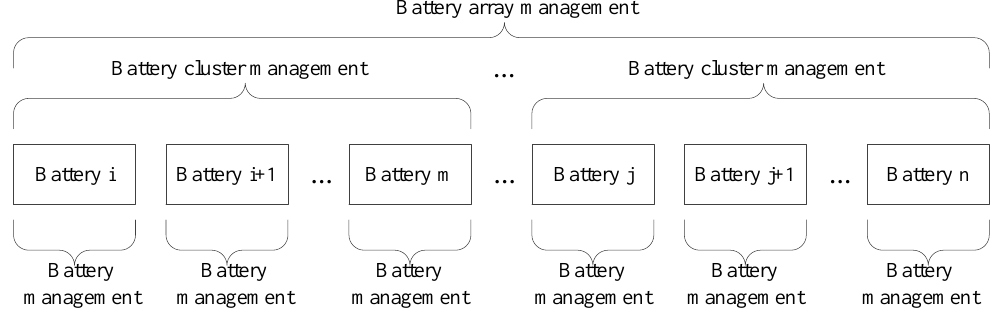
Figure 8. Hierarchical management structure of batteries.